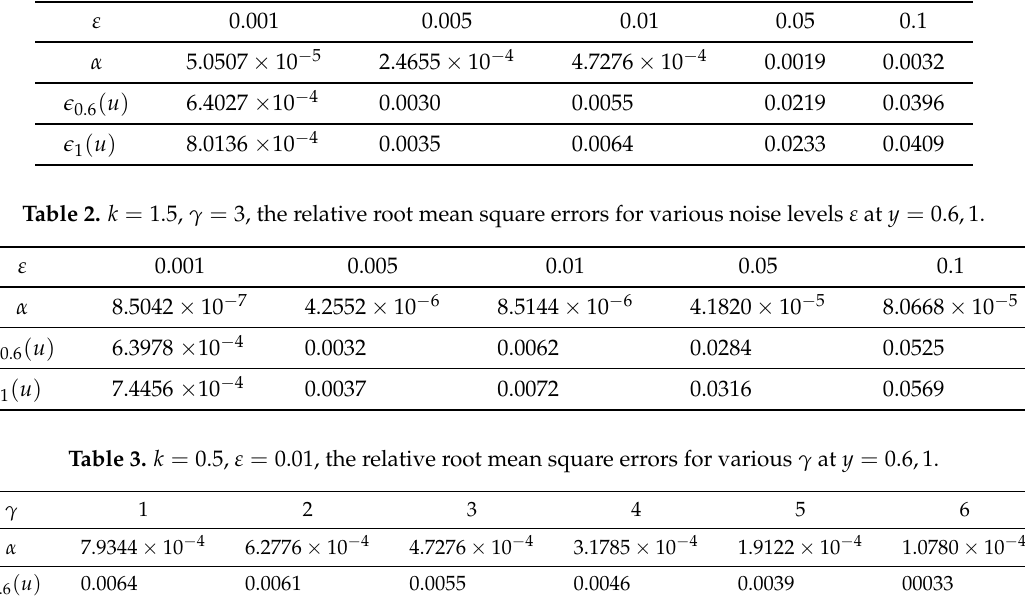
Table 1. k = 0.5, γ = 3, the relative root mean square errors for various noise level ε at y = 0.6,1.